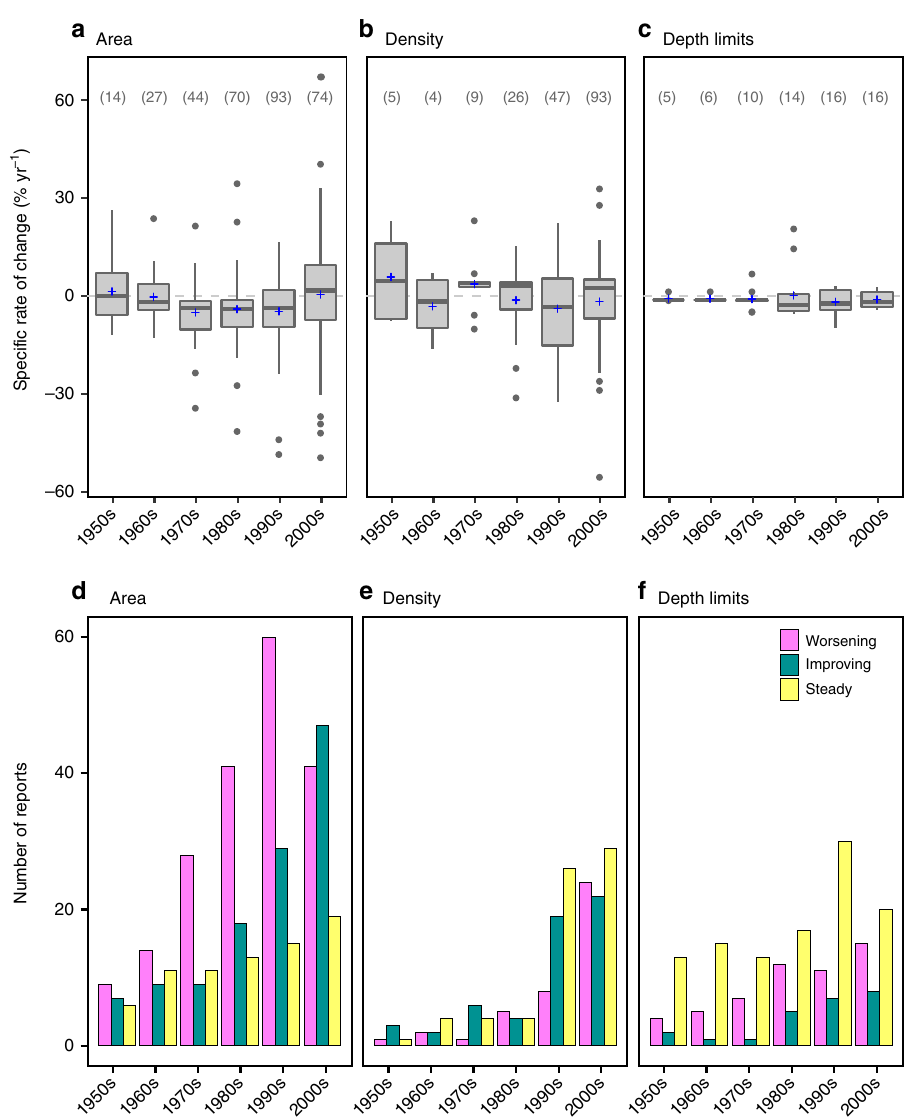
Fig. 4 Speci fi c rates of change and trajectory evolution of European seagrasses (1950s – 2000s). Speci fi c rate of change (% yr − 1 ) integrating sites showing either increase or decline trajectories in a area, b density, and c depth limits and number of sites where the trajectory improved, worsened, or stayed steady in d area, e density, and f depth limits. Decadal analysis includes time series >8 years. Number of reports per decade in a – c is given between brackets. In the boxplots, the plus ( + ) represents the mean, the solid line the median, the lower and upper hinges are the fi rst and third quartile, whiskers extends to the largest and smallest values no further than 1.5×inter-quartile range, and data beyond the end of the whiskers are plotted as